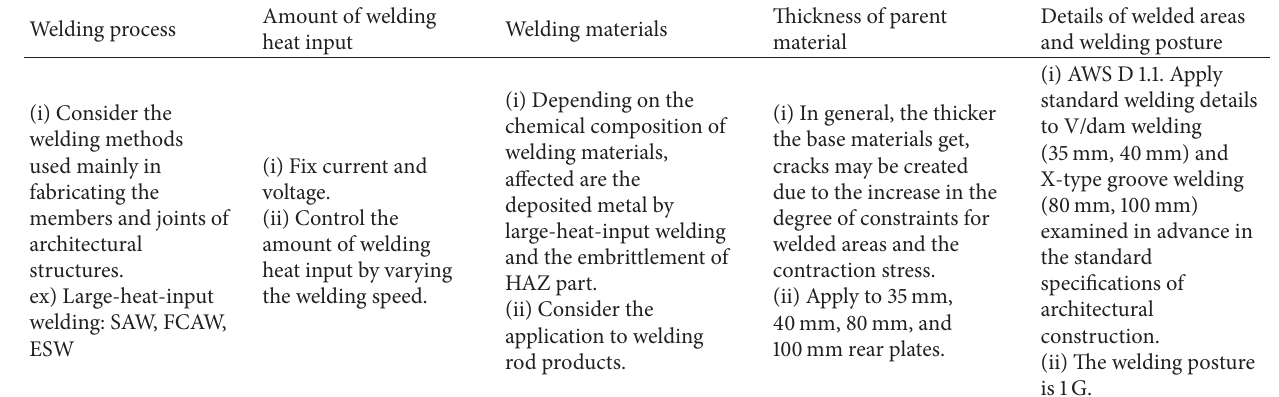
Table 1: Large-heat-input welding test